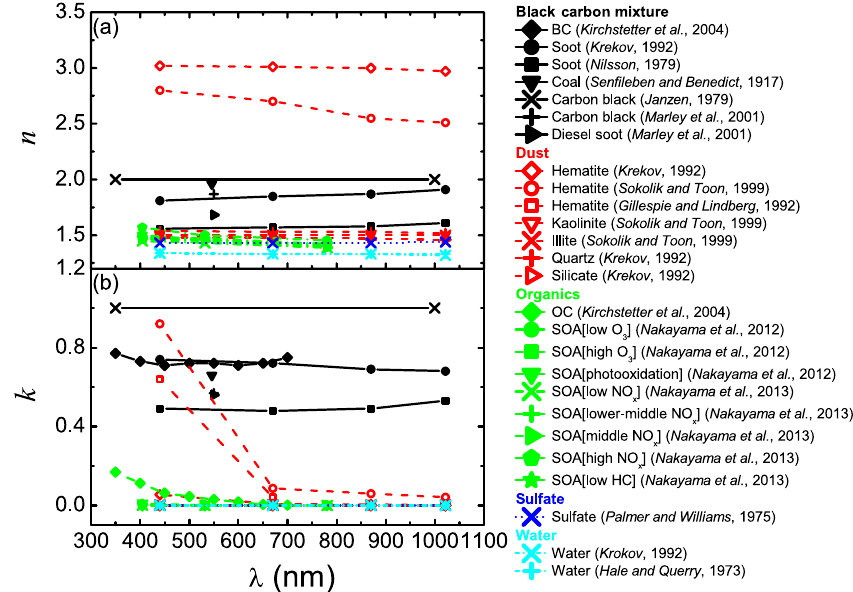
Figure 1. Complex refractive indices (real part: a; imaginary part: b) reported in the literature. Abbreviations are as follow: BC (black carbon), OC (organic carbon), SOA (secondary organic